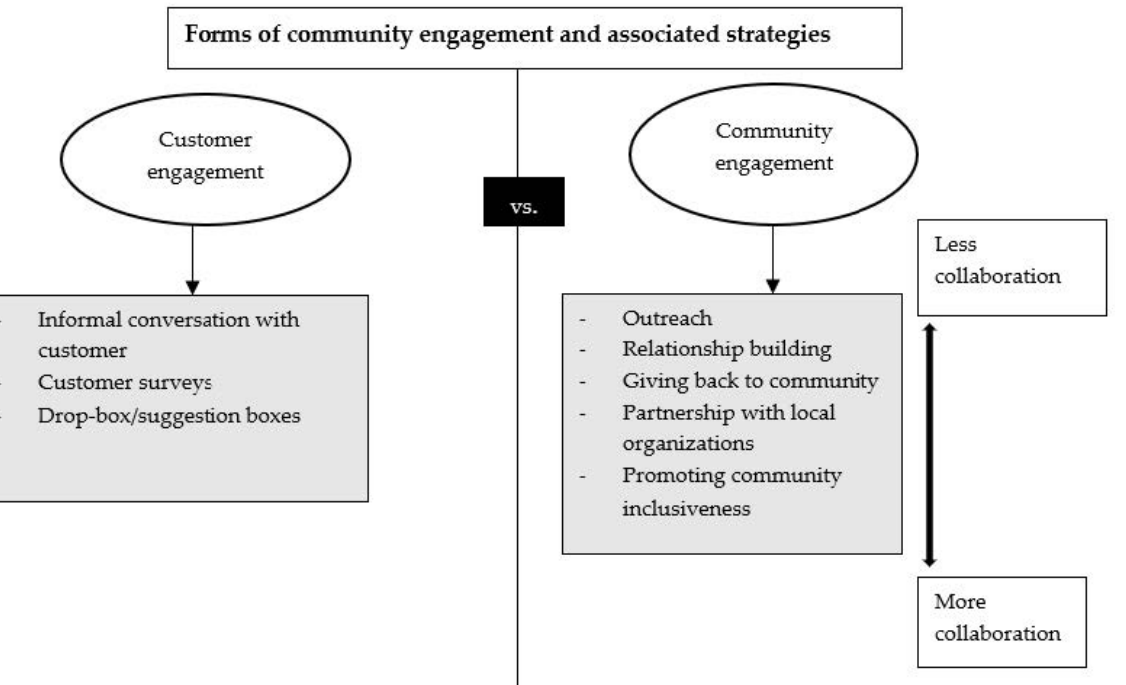
Figure 1. Forms of community engagement in neighborhood food retail stores and associated strategies.